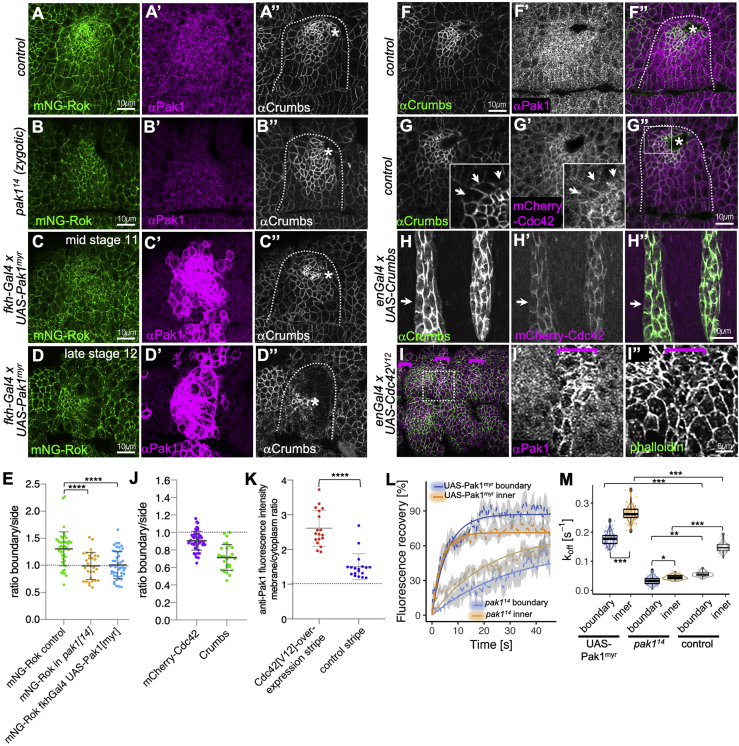
Pak1 Acts Downstream of Crumbs/Cdc42 and Controls Rok Planar Polarization and Cable Formation at the Placode Boundary(A–B″) In contrast to the wild type (A–A″) where Pak1 is enriched in the placode (A′) and mNG-Rok strongly accumulates at the placode boundary (A), in pak114 zygotic mutants Pak1 antibody labeling is strongly reduced (B′), and mNG-Rok is not polarized to the placode boundary (B, quantification in E).(C–D″) Overexpression of the membrane-targeted form of Pak1 in the placode (UAS-Pak1myrx fkh-Gal4) leads to a disorganized placode at stage 11 (C″) and a loss of mNG-Rok polarization (C, and quantification in E). At late stage 12, many UAS-Pak1myrx fkhGal4 placodes show a disruption that suggests a ripping of cells at the placode boundary (D″). mNG-Rok remains at remnant cell boundaries (D). (C′) and (D′) show the increased levels of overexpressed membrane-localized Pak1 by antibody staining.(E) Polarization quantification expressed as the intensity ratio of boundary junction versus side junction. Data are represented as data points, mean, and SEM. Mean values are as follows: mNG-Rok control = 1.304, mNG-Rok in pak114 = 0.99, and mNG-Rok in fkh-Gal4 UAS-Pak1myr = 1.006. Statistical tests used were unpaired t tests, and p values are indicated with ∗∗∗∗ being < 0.0001. Dotted lines indicate the placode boundary and asterisks the invagination point.(F–F″) Pak1 (F′ and magenta, revealed by anti-Pak1 antibody) is enriched in the salivary gland placode compared with the surrounding epidermis. Crumbs is shown in (F) and green.(G–G″) Cdc42-mCherry localization (G′ and magenta) follows endogenous Crumbs anisotropic localization (G and green) at the placode boundary; insets show magnification of boundary cells (arrows point to boundary membrane). Polarization quantification of mCherry-Cdc42 and Crumbs in corresponding cells expressed as the intensity ratio of boundary junction versus side junction (J). Mean values are as follows: mCherry-Cdc42, 0.906 and Crumbs, 0.714. Data are represented as data points, mean, and SEM.(H–H″) Overexpression of Crumbs (H and green) in enGal4 stripes leads to ectopic recruitment of mCherry-Cdc42 (H′ and magenta) to sites of ectopic Crumbs, again following the anisotropy (arrows).(I–I″) Overexpression of a constitutively active form of Cdc42, Cdc42V12, in enGal4 stripes leads to a strongly increased membrane association of Pak1 (magenta in I) in the overexpressing stripes. Membranes are labeled with phalloidin to reveal F-actin (green in I). (I′) and (I″) are magnifications of the box indicated in (I); data are quantified in (K).(K) Mean values are UAS-Cdc42V12x enGal4 stripe, 2.61 and control stripe, 1.50. Data are represented as data points, mean, and SEM. Statistical tests used were unpaired t tests; p value is indicated with ∗∗∗∗ < 0.0001. Dotted lines indicate the boundary of the placode, and asterisks mark the invagination point.(L and M) Modulation of Pak1 levels affects mNG-Rok koff. (L) Recovery curves fitted to data of FRAP experiments for boundary and inner junctions, respectively, for Pak1 overexpression (using UAS-Pak1myrx fkhGal4 n[boundary], 7 and n[inner], 18) and for the pak114 mutant (n[boundary], 5 and n[inner], 14). (M) koff values were estimated from the fluorescence recovery for the boundary [UAS-Pak1myr] as 0.17 (±0.022), for inner membranes [UAS-Pak1myr] as 0.266 (±0.025), for the boundary [pak114] as 0.032 (±0.013), and for inner membranes [pak114] as 0.044 (±0.008). Both Pak1 modulations were found to be significantly different from the control using a bootstrap procedure, with the p values determined as ∗∗∗ = 0.0002, ∗∗ = 0.008, ∗ = 0.013.See also Figure S5.